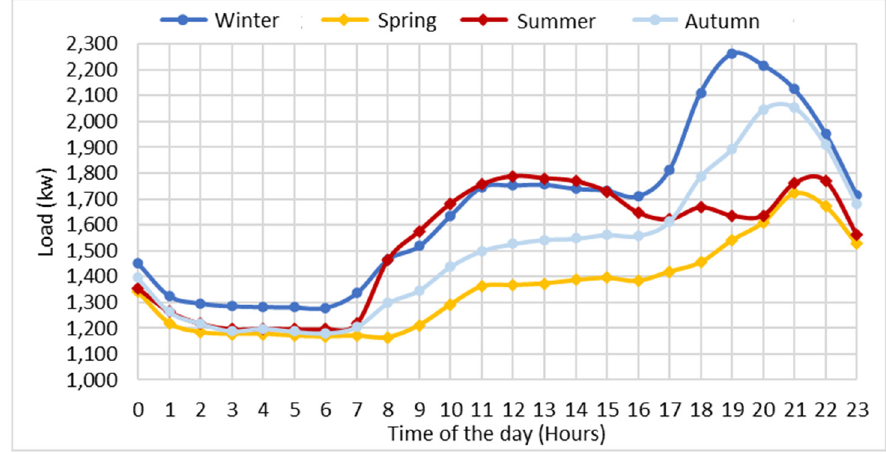
Figure 7. Average seasonal total load for the years 2018–2020.